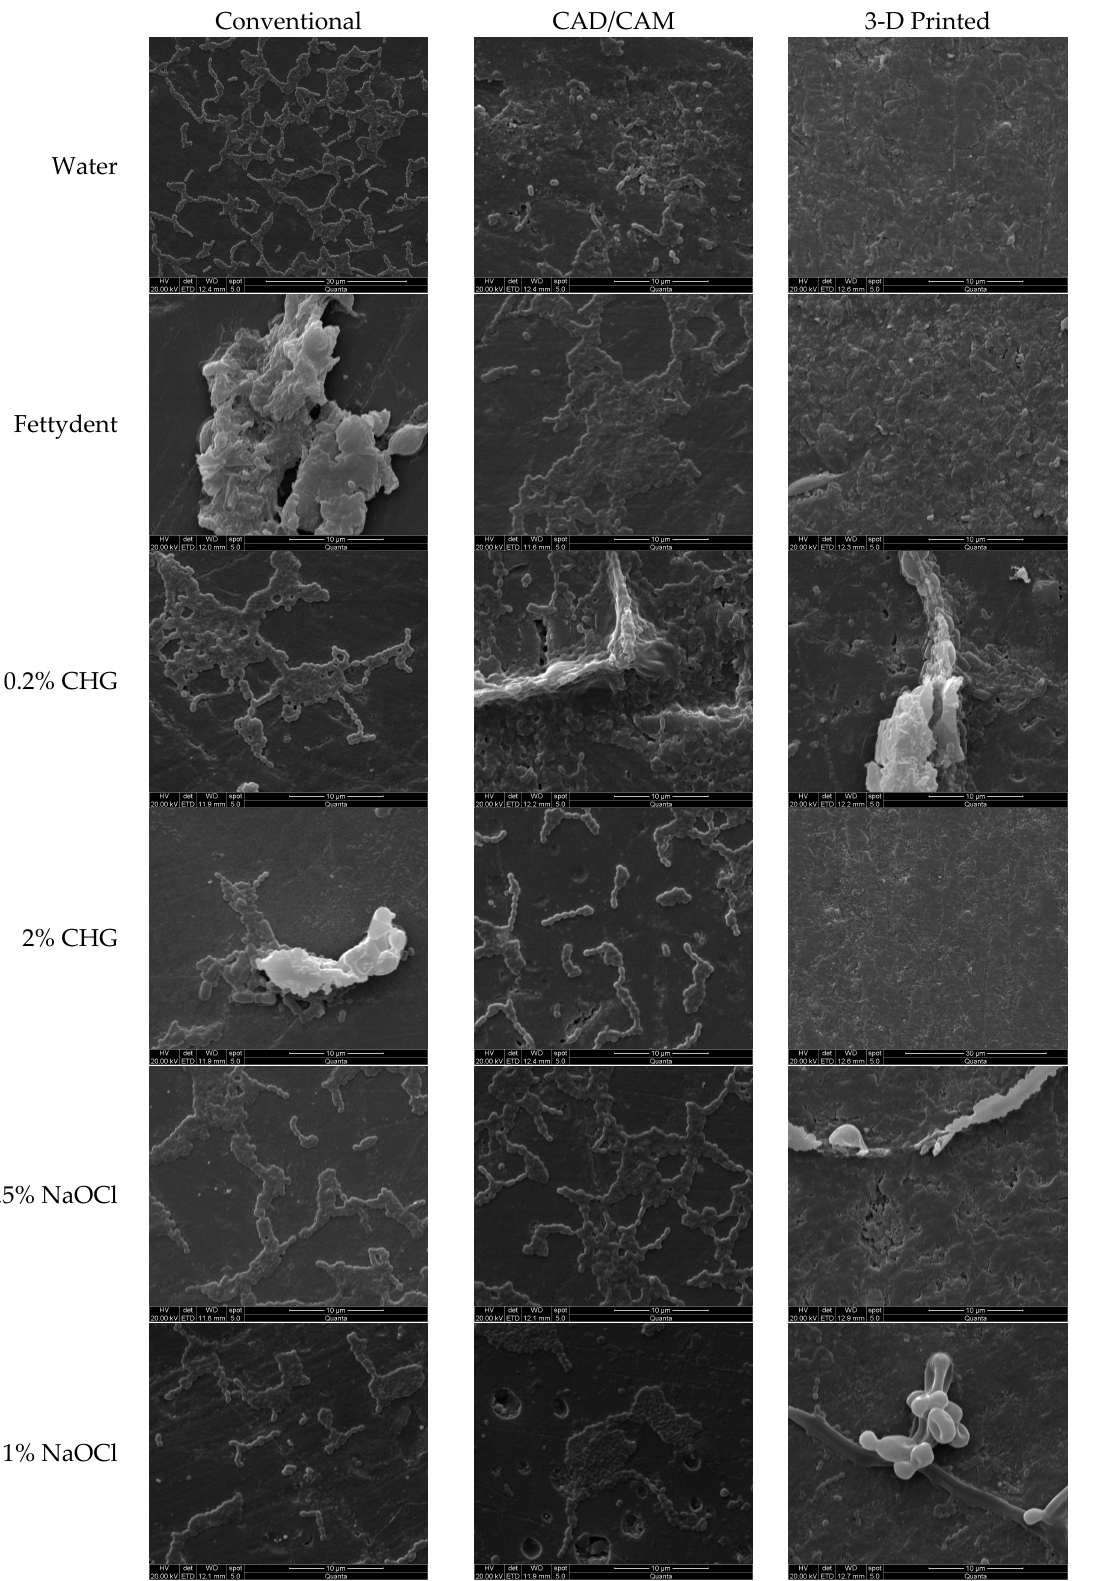
Figure 4. Scanning electron microscopy (SEM) images of the representative disc demonstrating the microbial growth on the